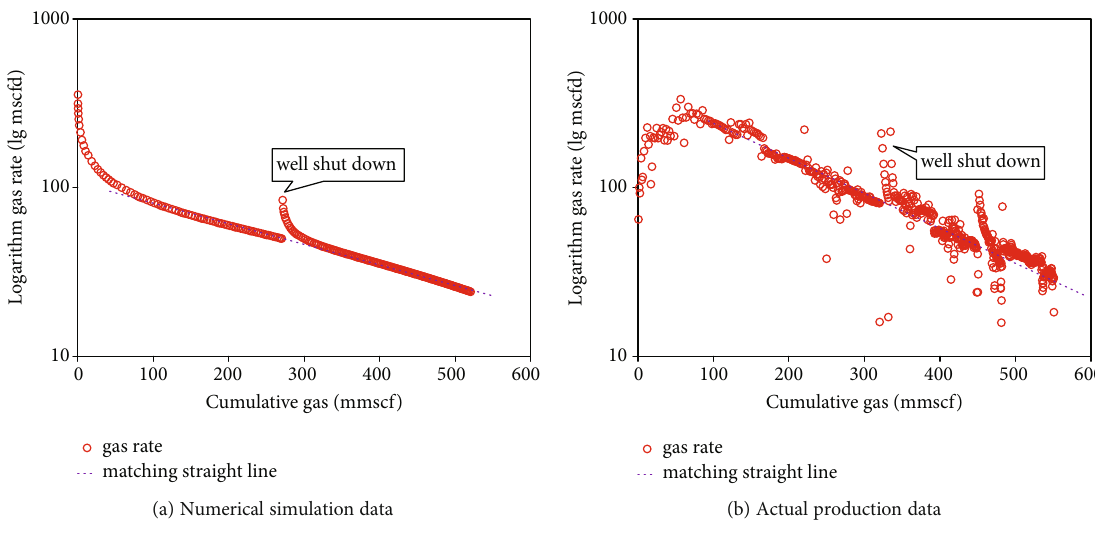
Figure 7: Production feature of resuming production after a temporary shutting